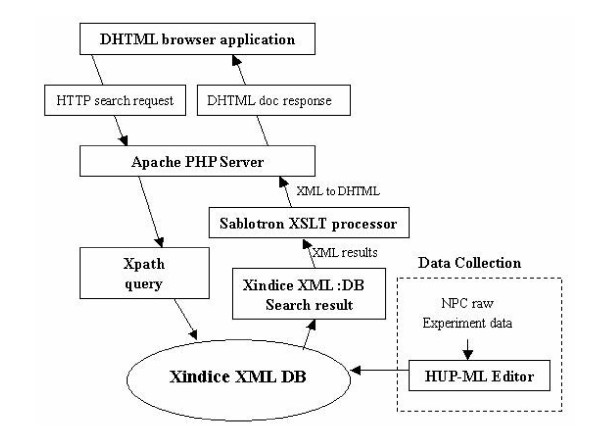
Architecture of exchange proteomics data. The figure showed the architecture of NPC repository and information flow of querying NPC 2D/MS repository.